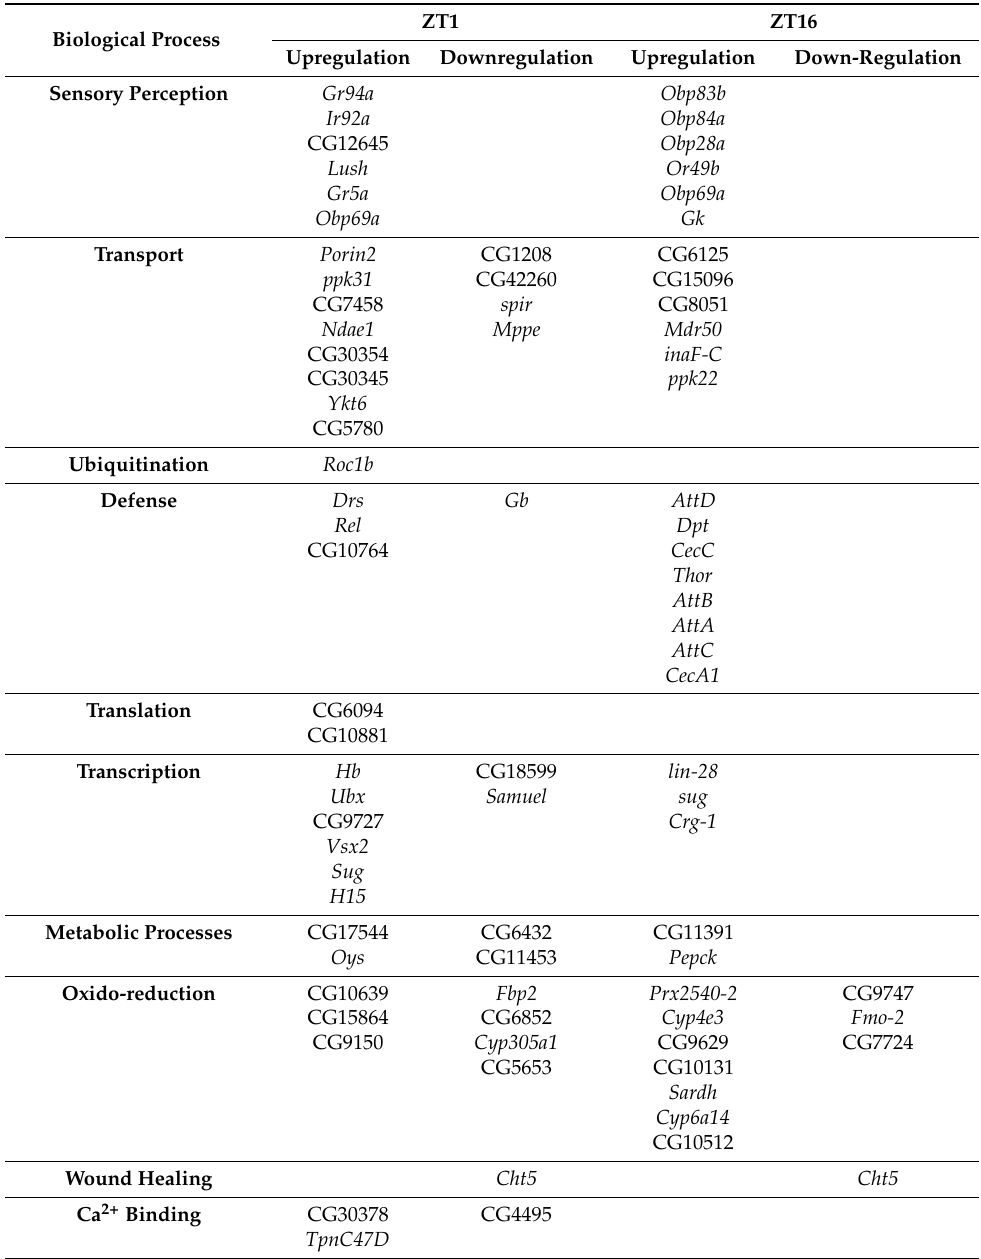
Table 2. List of genes up—and downregulated after heme oxygenase ( ho) RNAi expression under the Glass Multiple Reporter (GMR)